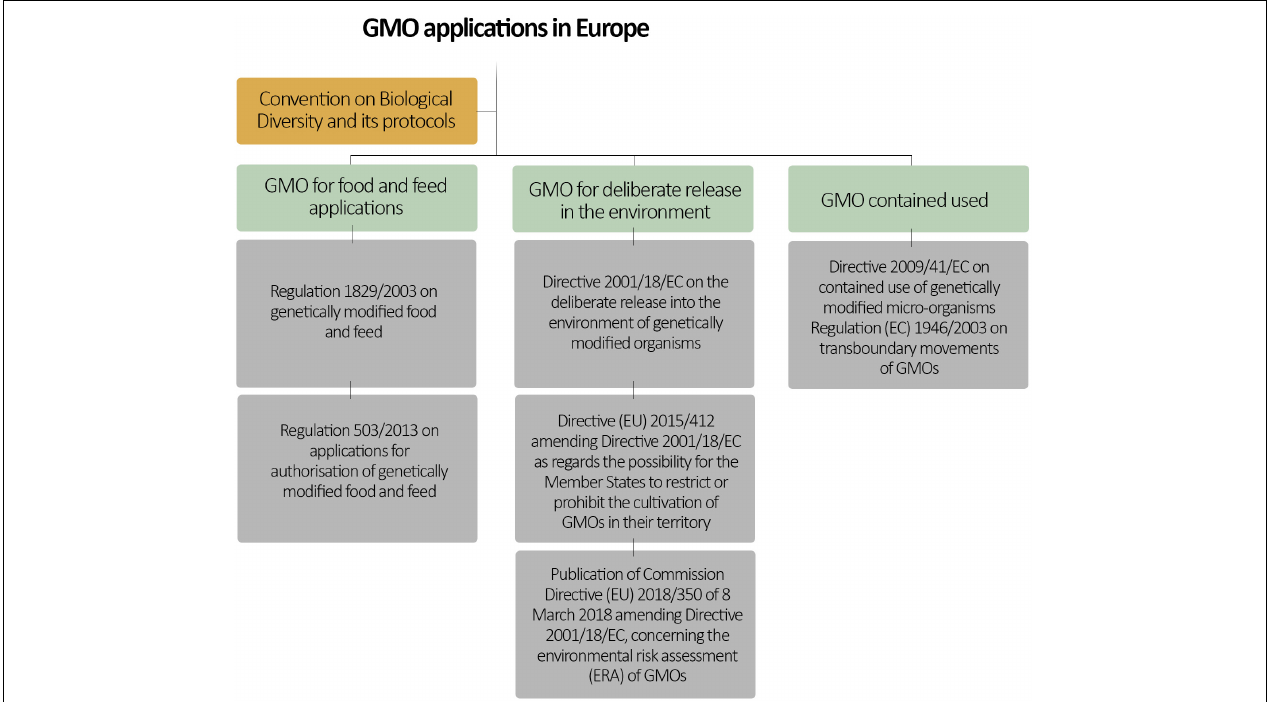
FIGURE 1 | European regulatory framework for GMOs. Note that European Union is also a signatory to the United Nations Convention on Biological Diversity and its related protocols. Therefore, it can be also considered as part of the European GMO regulatory